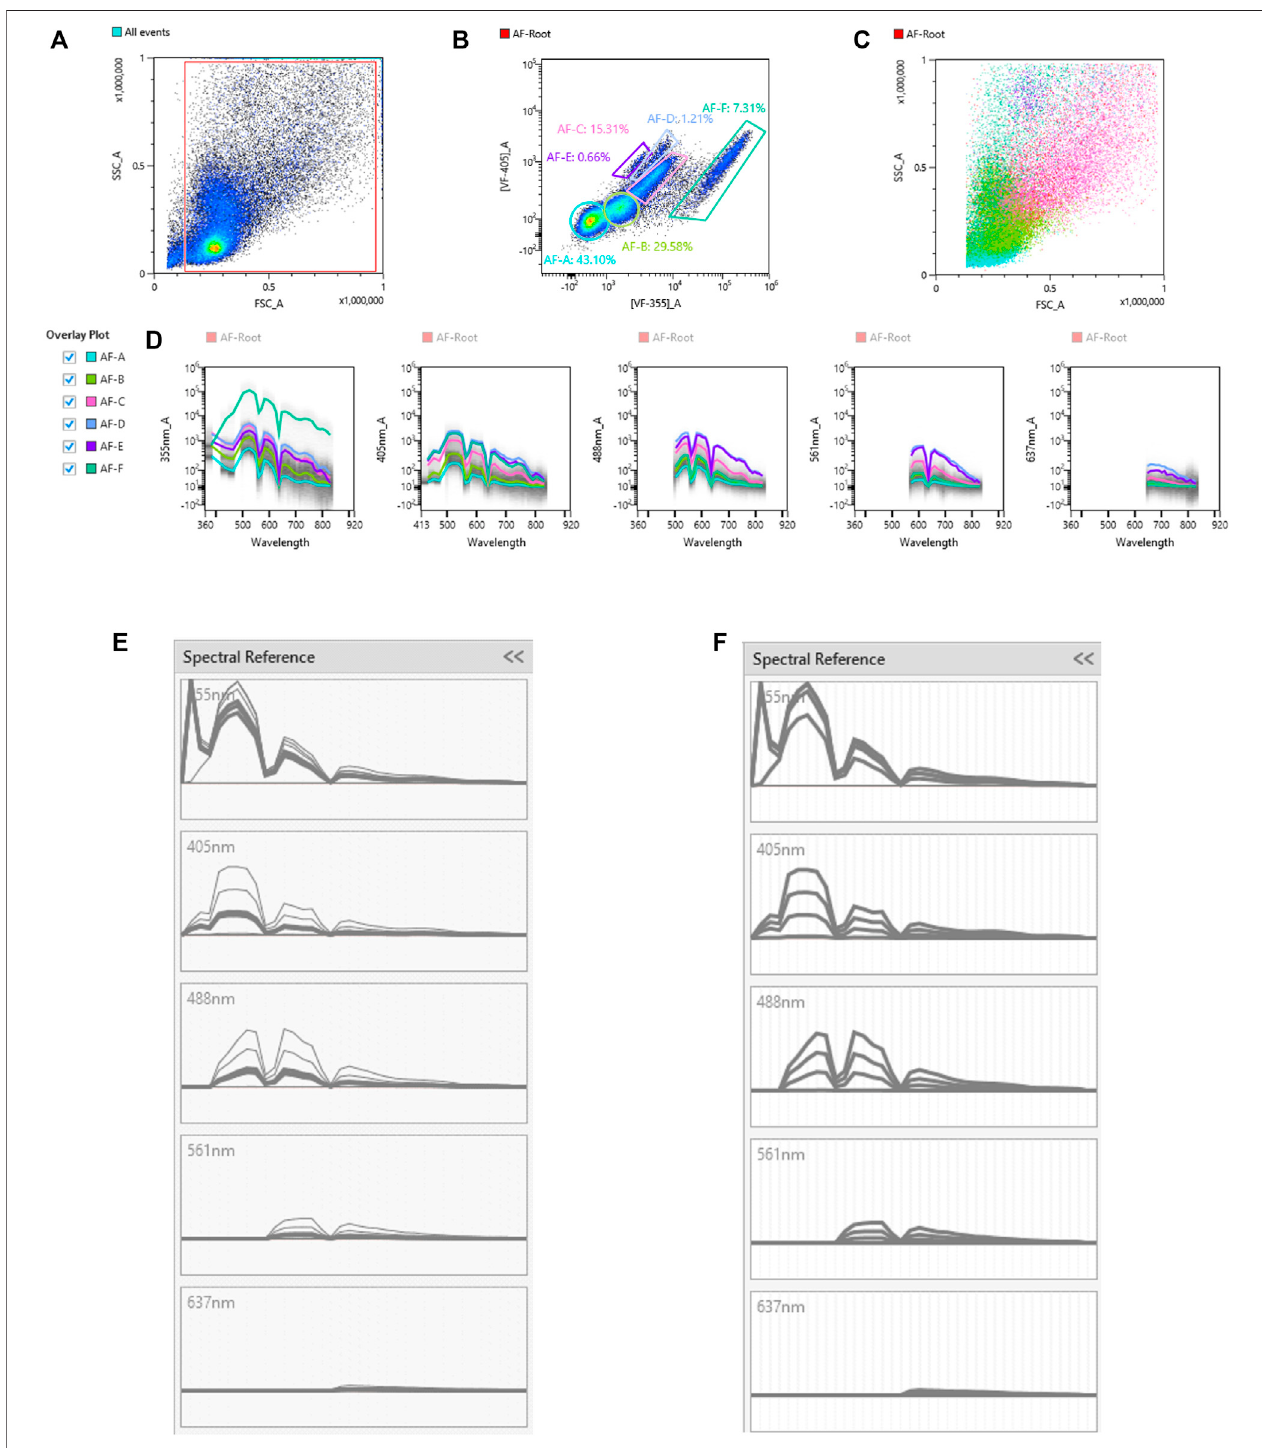
FIGURE1| Identi fi cationofuniqueauto fl uorescentpopulationsinanunstained sampleusingauto fl uorescence fi ndertool.Theunstained samplewithnounmixing appliedwasloadedintotheauto fl uorescence(AF)Findertool.TheAF-Rootgatewascreatedtodistinguisheventsusedintheanalysisfromthedebris (A) .Virtual fi ltersin the violet range (VF-405; y -axis) and ultraviolet range (VF-355; x -axis) were used to view the events from the AF-Root gate. Populations that separate were gated as possibly unique AF populations (B) . The scatter plots (C) as well as spectral traces (D) for these AF populations were displayed. The spectral trace for each AF populationwasoverlaidandevaluatedtodeterminewhichAFpopulationswereunique.ThespectraltracesforpopulationsA,B,andC[boldedtracesin (panelE) ]were determinedtobenearlyidentical.Sincethesetracesarethesame,onlyoneofthesepopulationswasusedinthespectralunmixing.PopulationsA,D,E,F[boldedtraces in (panel F) ] were unique AF spectra and each was used in the spectral unmixing.